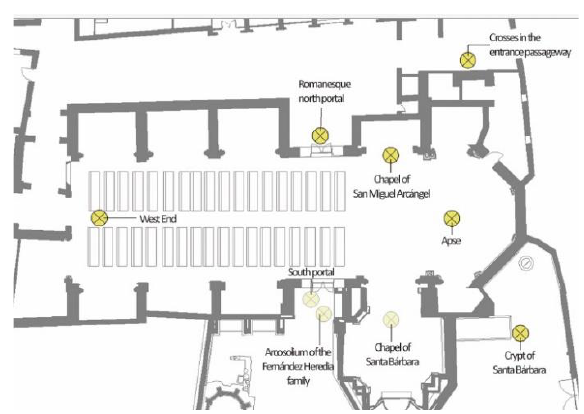
Figure 3. 2D view highlighting the resources with the highest attraction value. Source: Authors’ own work.